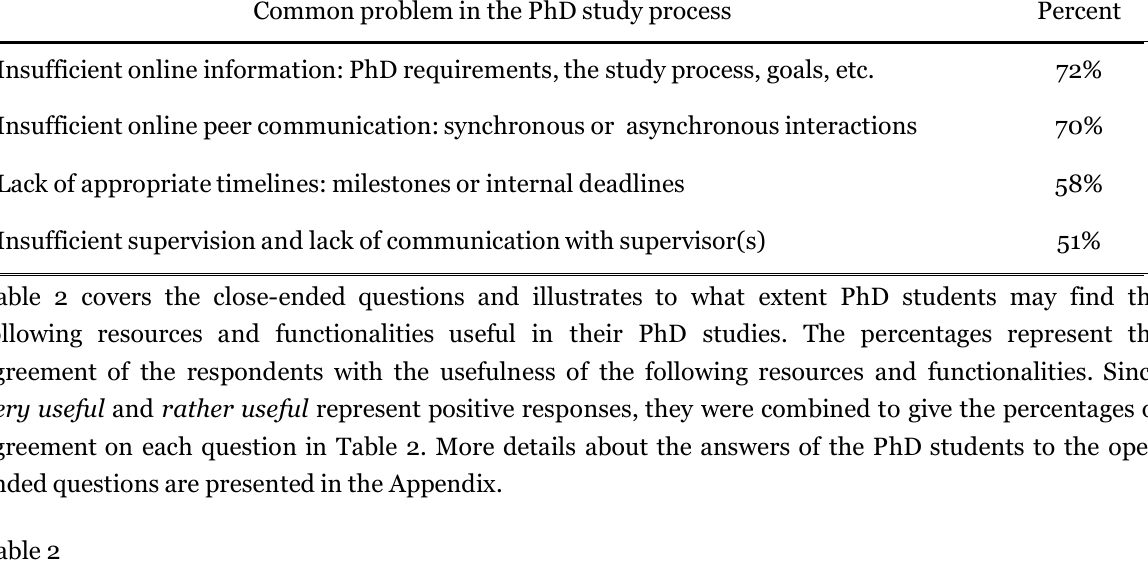
Sorted Functionalities and Resources of the ICTSS Based on the PhD Students’ Perceptions of their Usefulness Usefulness of the ICT 4 PhD resources and functionalities >= 90% Online access to travel information: travel insurance, traveling steps and formalities, traveling information about conference fees, and booking